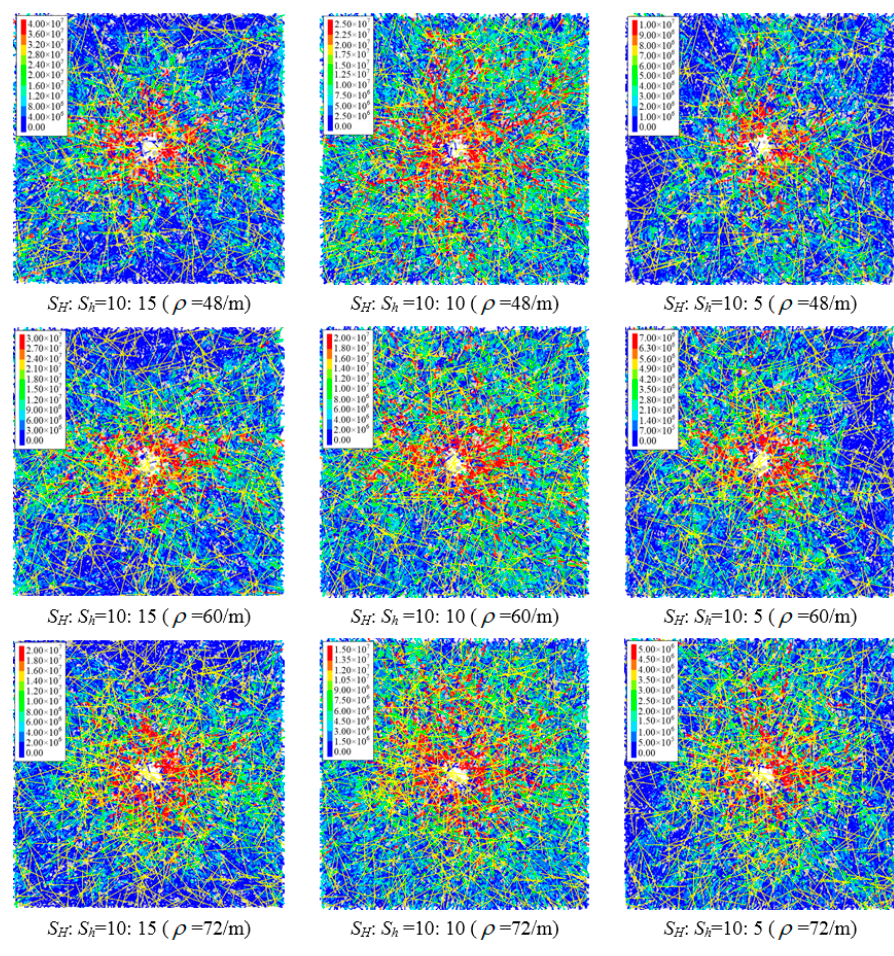
Figure 20. Change of injection pressure with CPR when NF density ranges from 24/m to 72/m and injection rate is 2.0 × 10 − 6 m 3 /s.